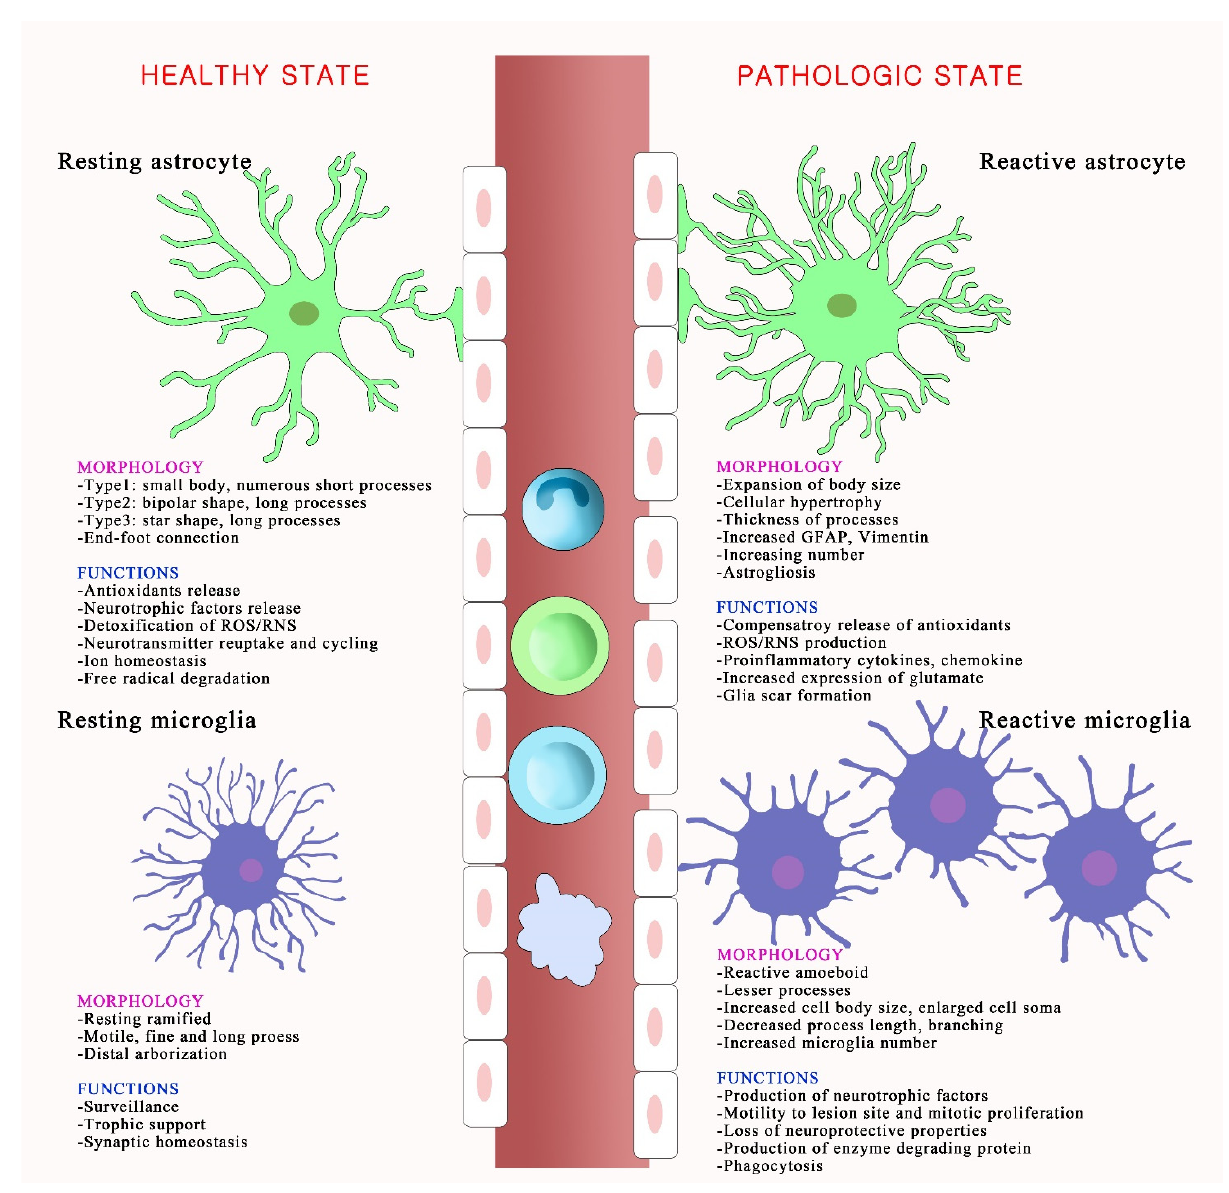
Figure 2. Schematic depicting morphological and functional changes in activated glial cells following oxidative stress. The resting and reactive states of astrocytes and microglia have different morphologies and functions. In a healthy brain, astrocytes are called territorial cells and they maintain extracellular homeostasis via numerous cellular processes. Microglia use their defense mechanisms to rapidly respond to disturbances in the brain environment, and assist in specific immune functions. However, under oxidative stress, reactive astrocytes undergo astrogliosis, which associates with cellular hypertrophy, astrocyte proliferation, increasing numbers and thickness of processes, and expanded cell body size. Reactive microglia, also called amoeboid microglia, exhibit morphological modifications and proliferation and produce several inflammatory mediators, including nitric oxide and superoxide. The disruption of vascular integrity is observed and increases the permeability of immune cells in pathological